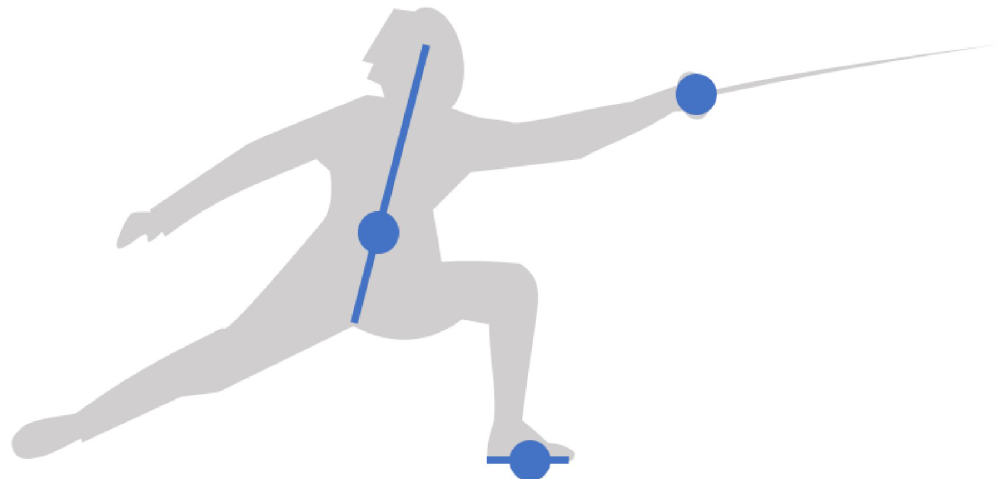
Fig 19. Lunge space. It is defined by the body center (at 1 of the trunk segment), the sword hand and the front foot (in the 3 middle of the foot segment). These three points of interest are comparable to the mass center, the weapon and the front foot studied by Chen et al. [17] and Gutierrez-Davila et al.